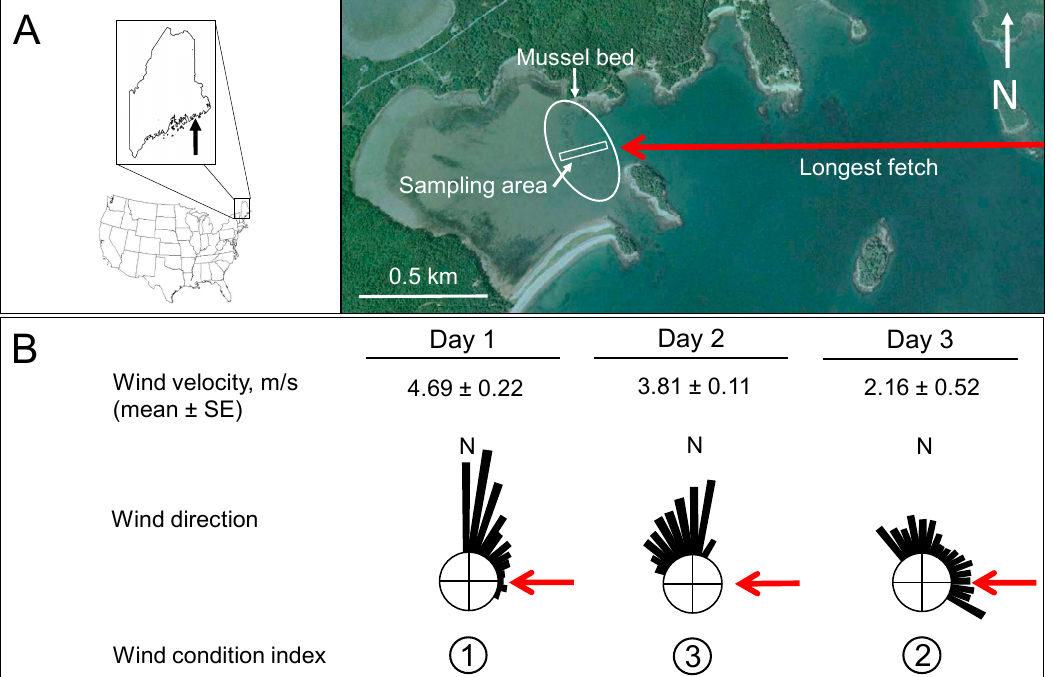
Figure 2. ( A ) Study site at Carrying Place Cove, Harrington, Maine, USA. Longest fetch is from the east, indicated by red arrow. ( B ) Wind condition index (Day 1 > Day 3 > Day 2) created by combining wind velocity and fetch values when the bottom was covered with water during the three days of the investigation. Map data copyright 2015 Google.